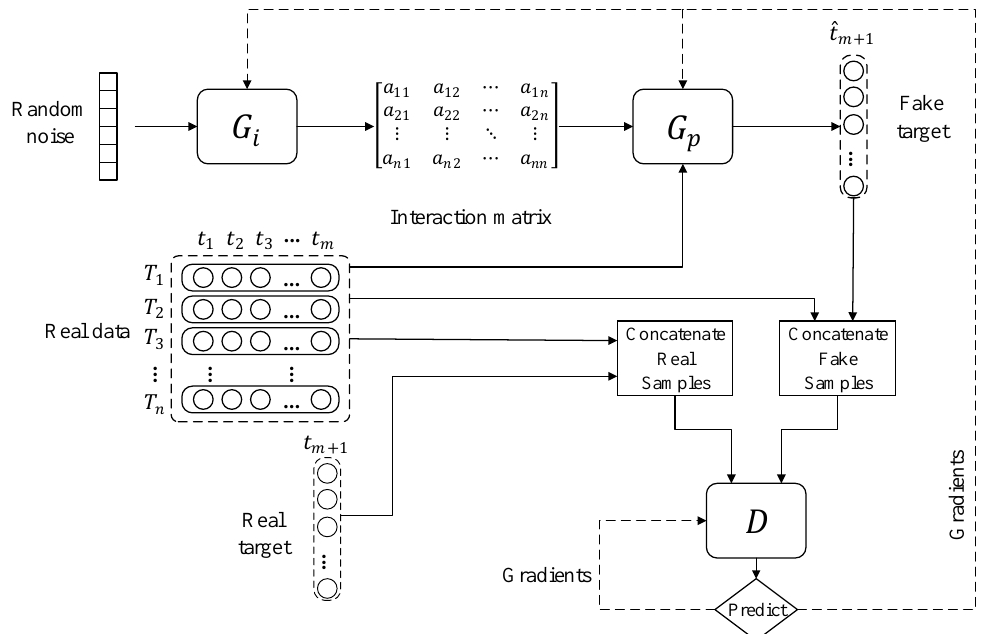
Figure 2. The architecture of the Multiple Time Series Generative Adversarial Network (MTSGAN). The overall workflow of MTSGAN can be divided into a generation process, a discrim- ination process and an adversarial process. In the generation process, first, the interaction matrix generator transforms a random noise vector into an interaction matrix and then combines the interaction matrix with the time series feature matrix to construct a time series interaction graph. Next, the prediction generator capturea the interactional dependencies between time series and temporal dependencies within each time series to generate the predicted value of each time series. In the discrimination process, first, it is necessary to construct real samples and fake samples. We use the real data represented by the time series feature matrix and real targets to obtain real time series samples through matrix concate- nating operation, as well as use the real data and fake targets generated by the prediction generator to obtain fake time series samples through matrix concatenating operation. Then, the discriminator will use real samples and fake samples as the training set for training. When it can correctly distinguish between real samples and fake samples, the discriminator training is completed. In the adversarial process, the well trained discriminator is fixed as the generators’ evaluator, and the network parameters of two generators are adjusted to maximize the probability that the fake samples generated by the two generators are judged to be real samples by the